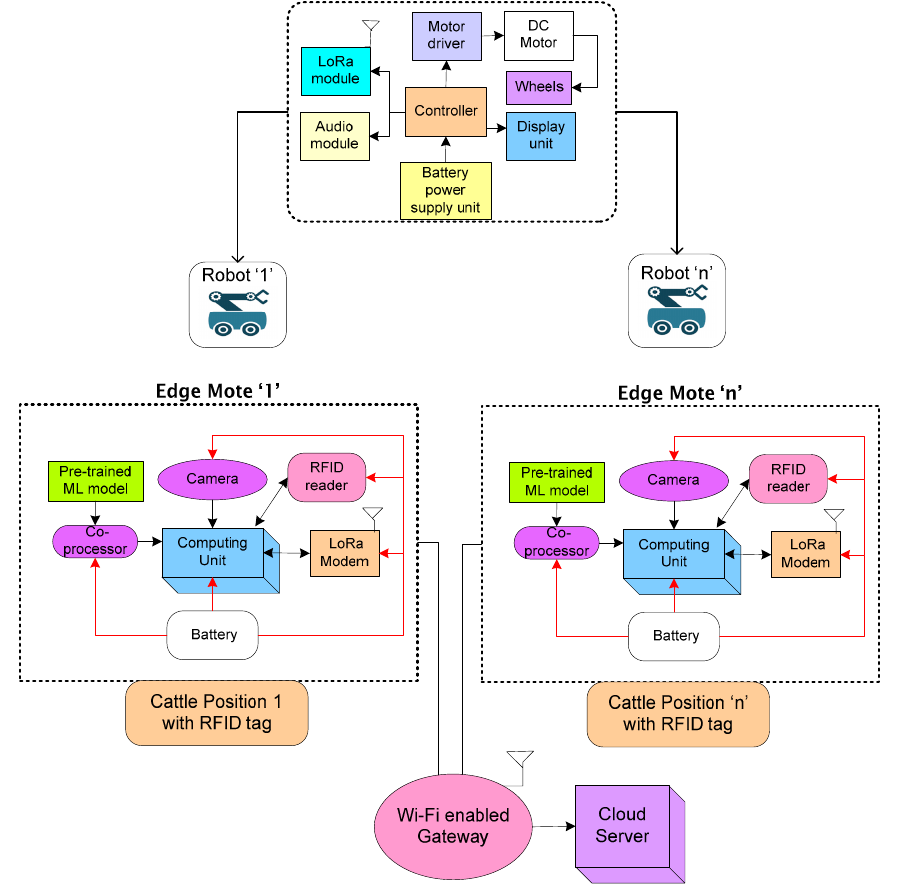
Figure 8. IoT and Robotics Inspired architecture for diet planning and feeding.